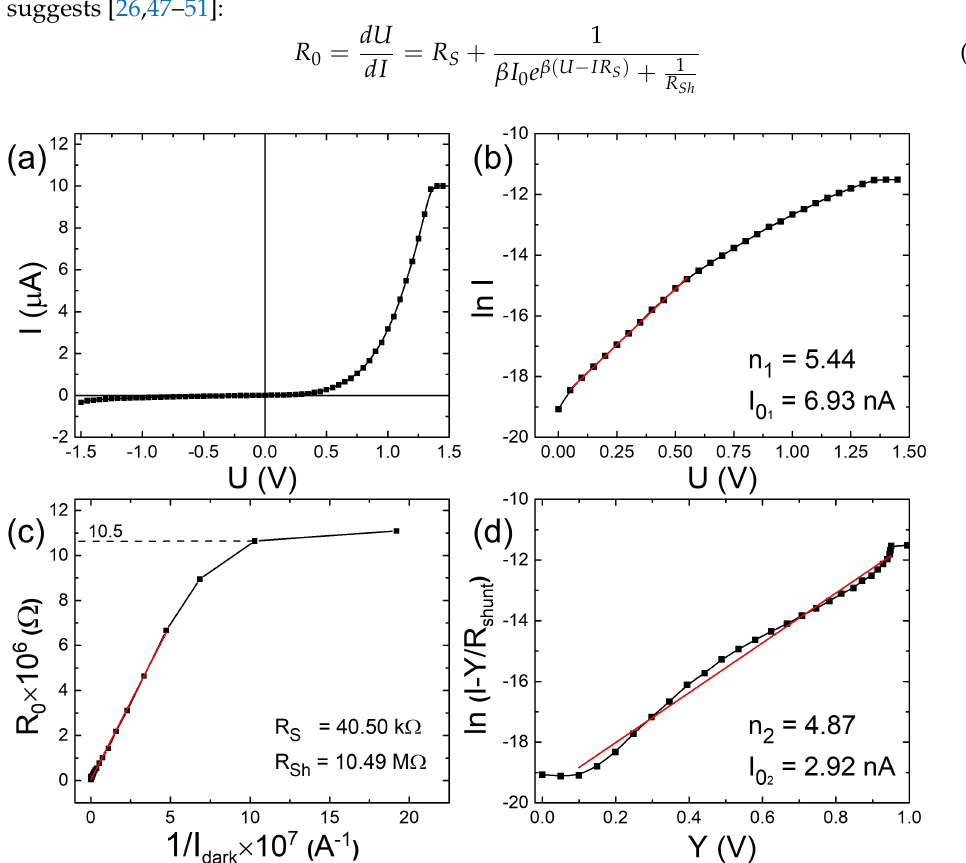
Figure 5. ( a ) Current –voltage (I–V) dark ambipolar characteristics recorded at room temperature of the Au/ZnTe/ZnSe/ZnO/ITO “sandwich” structure; ( b ) semi-logarithmic fit (ln I vs. U ) at forward bias, allowing the determination of ideality factor and saturation current; ( c ) dependency of R 0 as a function of reciprocal dark current permitting the evaluation of series and shunt resistances; ( d ) linear representation, i.e., ln ( I − Y / R Sh ) vs. Y , illustrating the more accurate determination of the ideality factor and saturation